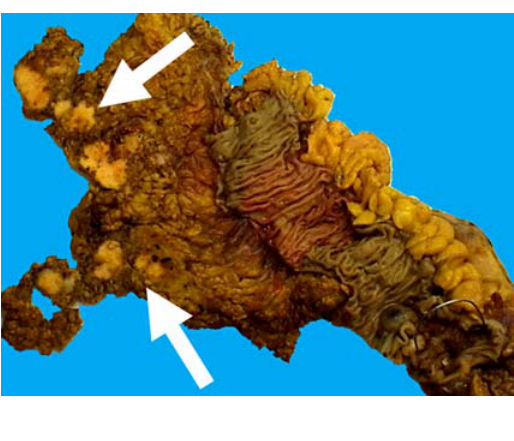
Figure 3. Macroscopic image of right hemicolectomy specimen showing multiple peritoneal tumor deposits (arrows).